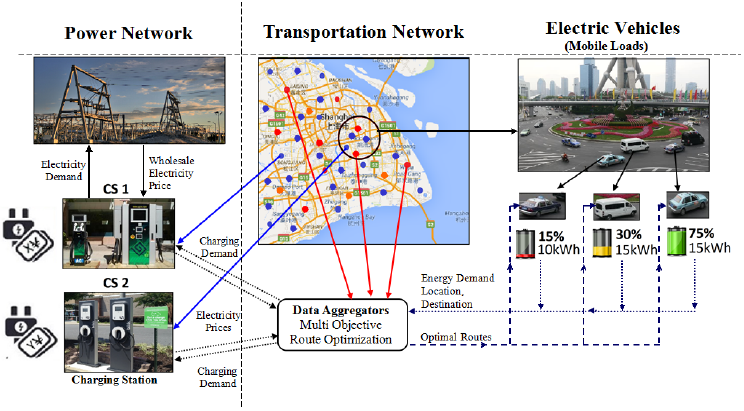
Figure 1. General framework for simultaneous operation of electrified transportation and power